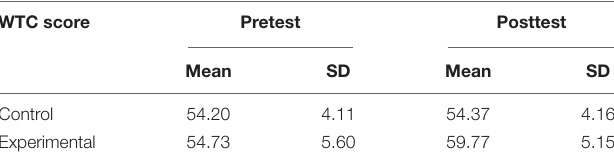
collected data were analyzed, and Tables 10 , 11 show this analysis.